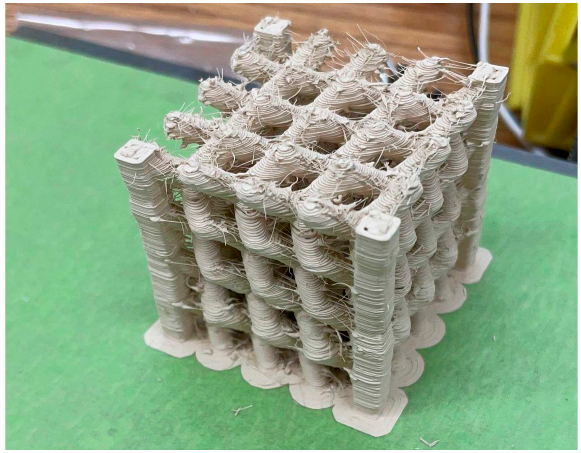
Figure 10. 3D photonic crystal.